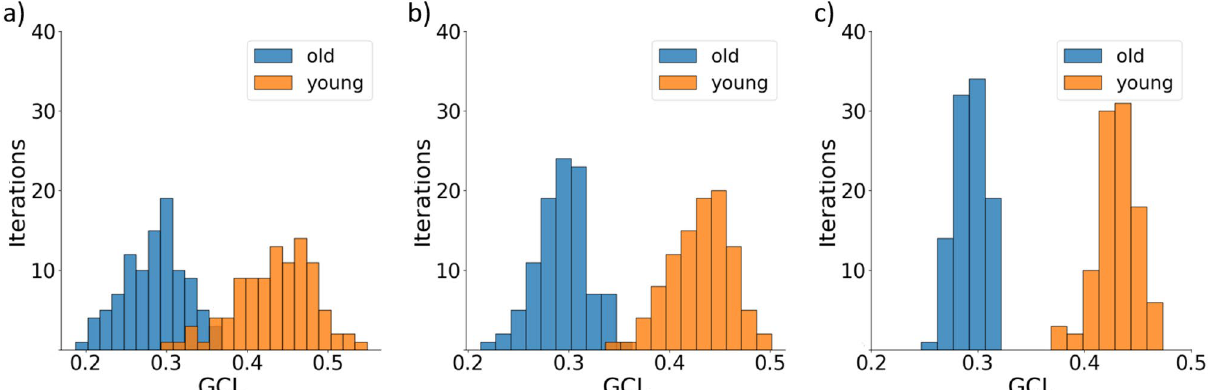
Figure 5. Demonstration of the GCL implementation. An example of the use of the GCL Python script. Two cohorts of gene expression tables of LT-HSCs 19 from young and old organisms are compared with respect to their GCL values. The user chooses the number of jackknife realizations, s (in this case s percentage of re-sampled cells in each realization from the entire cohort. ( a ) 50% , ( b ) 70% , ( c ) 90% . The function plots the values as a histogram. The characteristic decrease in GCL values with age is apparent 15 . Increasing the percentage of cells decreases the variance of the